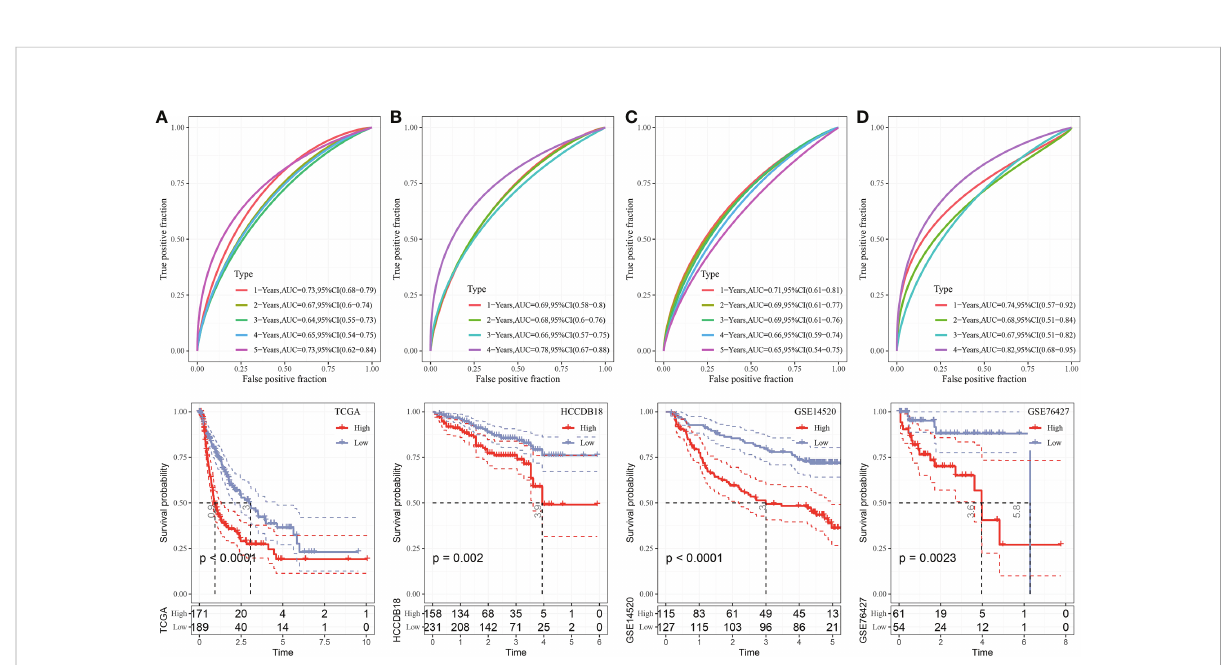
FIGURE 9 Validation of RiskScore. (A) ROC and K – M survival analysis of RiskScore in TCGA-LIHC dataset. (B) ROC and K – M survival analysis of RiskScore in the HCCDB18 dataset. (C) ROC and K – M survival analysis of RiskScore in the GSE14520 dataset. (D) ROC and K – M survival analysis of RiskScore in the GSE76427